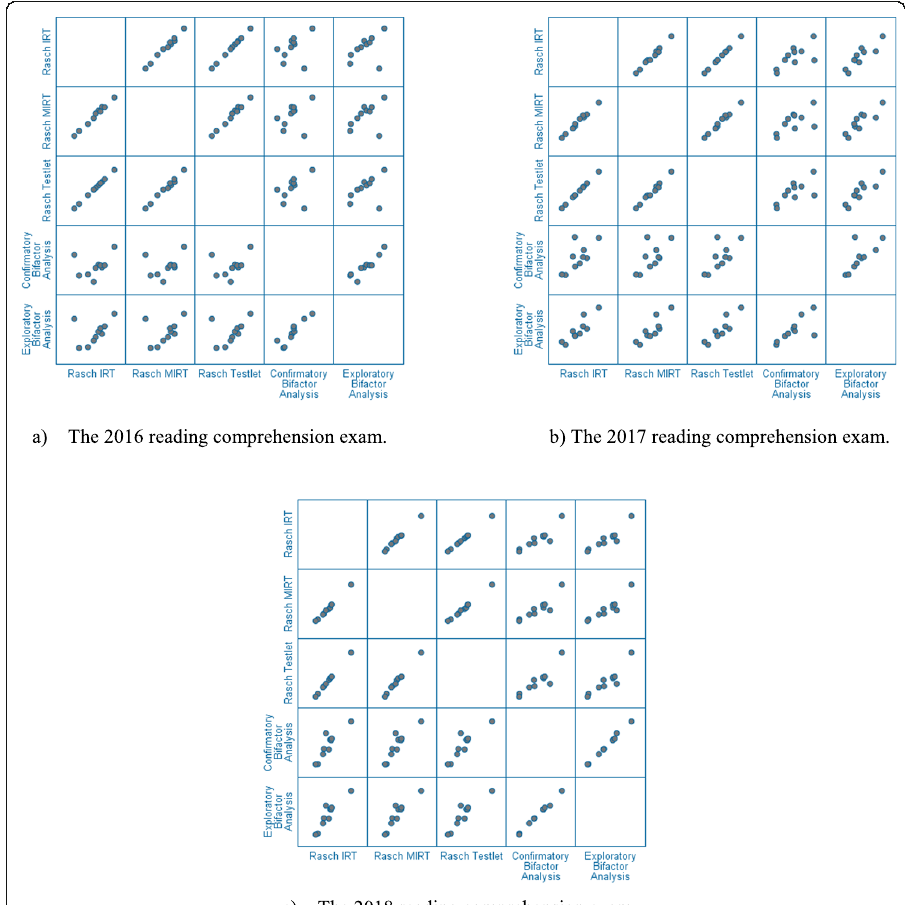
Fig. 4 Matrix scatter plot of item difficulty parameters in the applied Rasch and the bifactor models